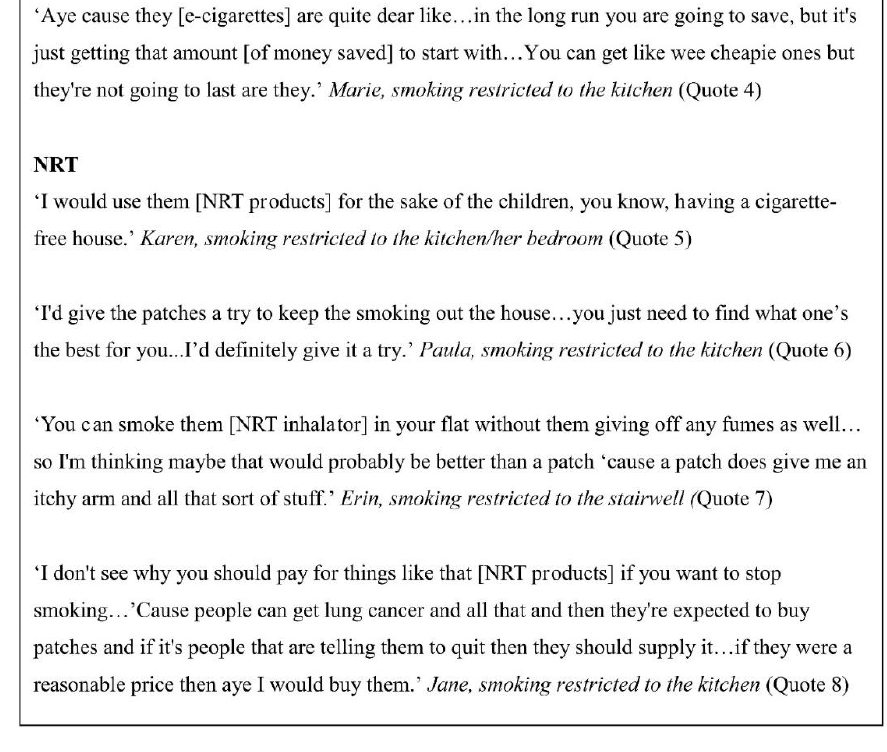
Figure 2. Parents’ views on using e-cigarettes and nicotine replacement therapy (NRT) to create a smoke-free home.